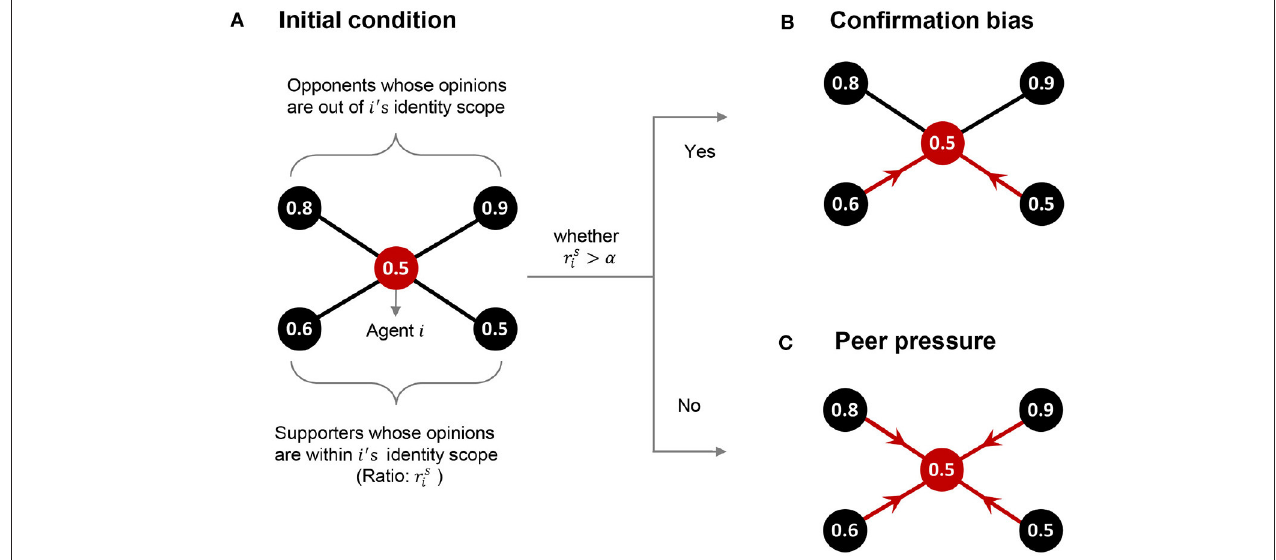
FIGURE 1 | Schematic of dynamical model. (A) Initial condition. Agent i passively receives information from neighbors. According to their claims, agent i divides neighbors into two classes: supporters whose opinions are within its identity scope (nodes in the bottom) and opponents whose opinions are out of its identity scope (nodes in the top). If the ratio of supporters is more than a threshold ( r s i > α ), agent i would go through (B) confirmation bias and tends to update its opinion in its comfortable cognitive region by only interacting with supporters. Otherwise, agent i experiences (C) peer pressure and updates its opinion by interacting with all